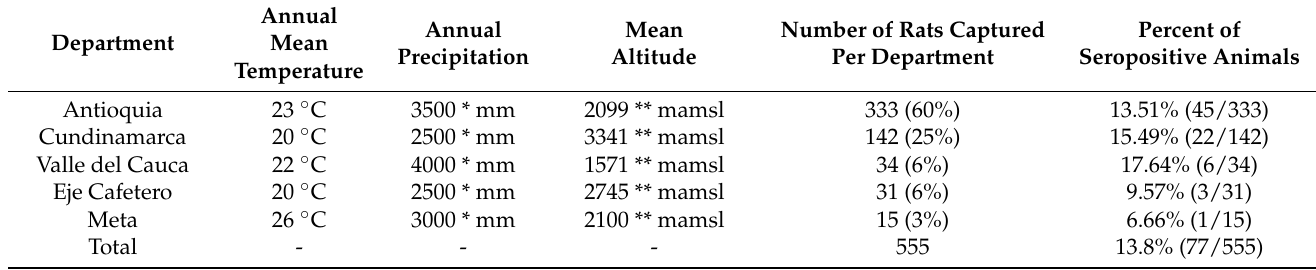
Table 2. The layout of the temperature, precipitation, altitude, number of rats captured, and percent of seropositive rats for Leptospira spp. found in pig farms by